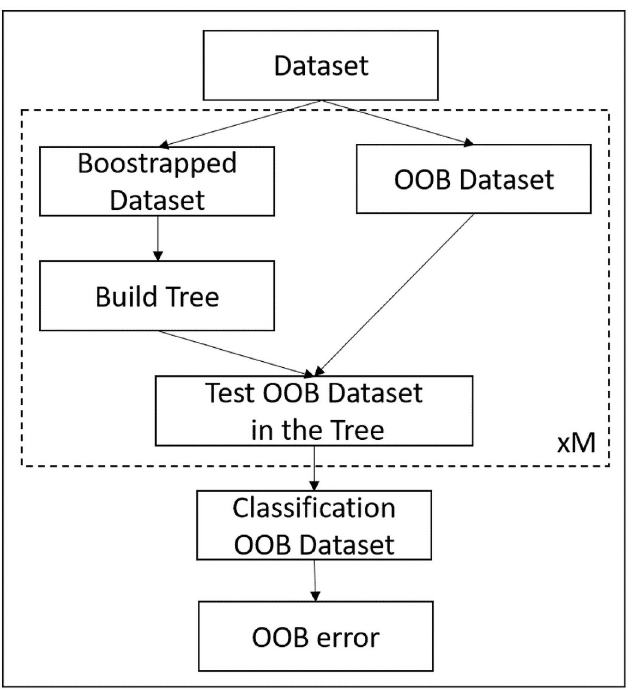
Fig 3. Out-of-bag process. The procedure inside the dotted rectangle is performed for each one of the M trees on the ensemble.